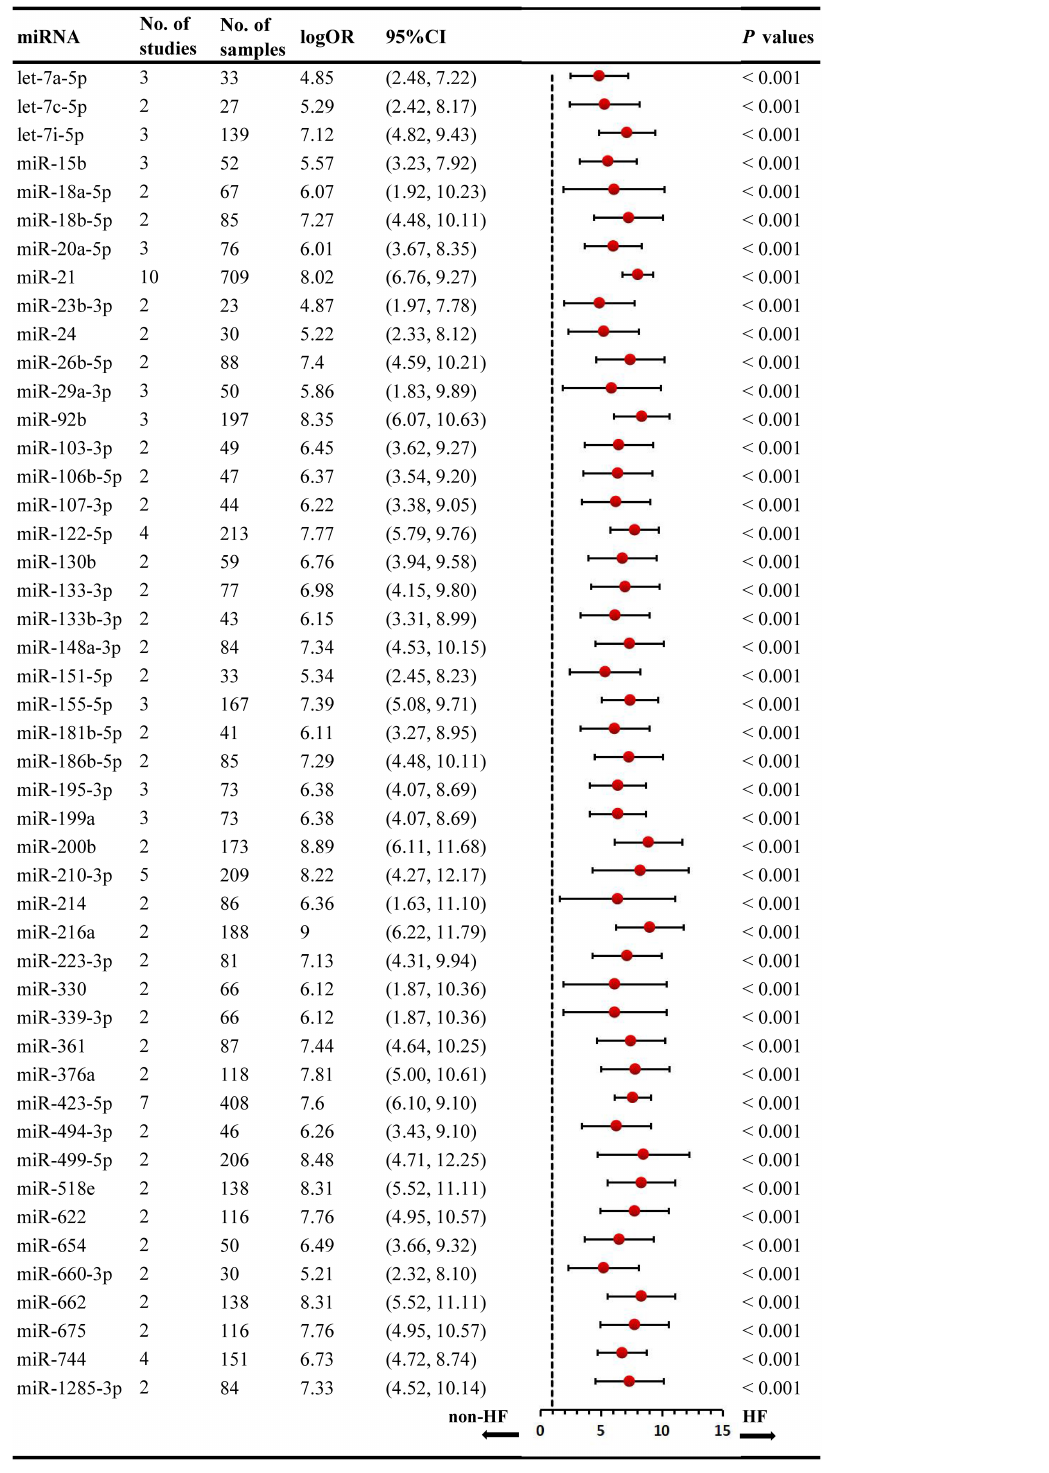
FIGURE 3 | Statistically significant up-regulated miRNAs in overall analysis. miR, microRNA; No, number; HF, heart failure.